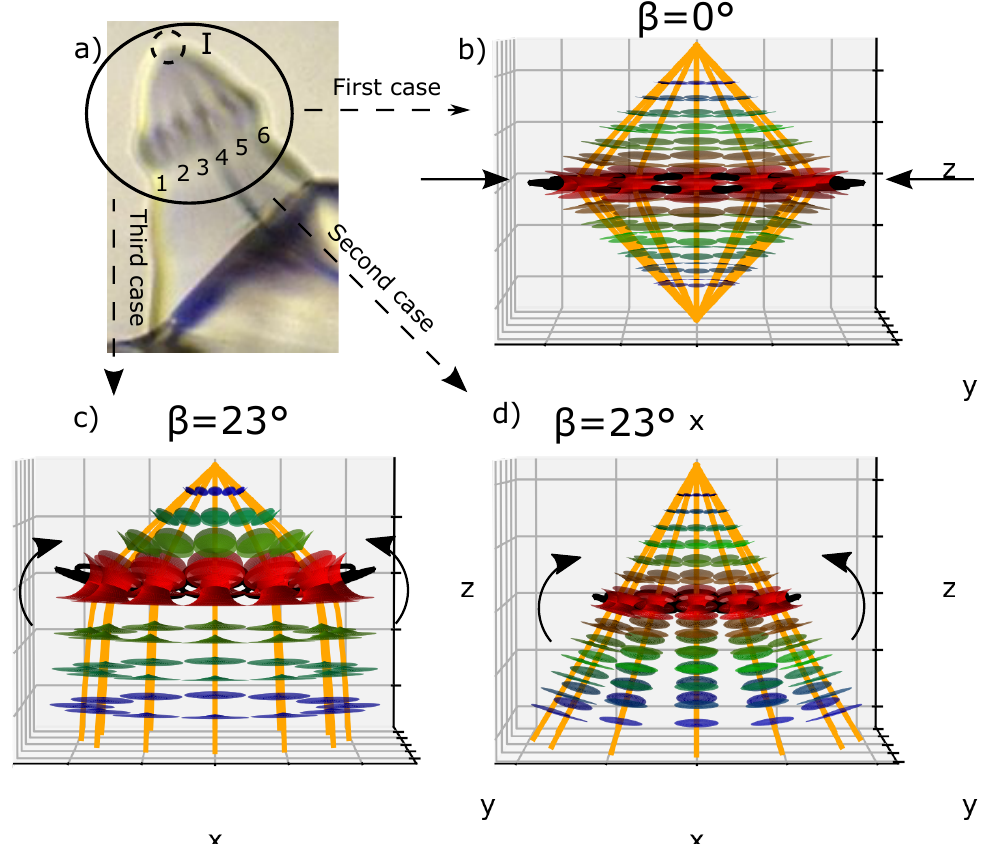
Figure 9. ( a ) Recall of the bâtonnet obtained in POM observation; ( b , c ) represent respectively the flatten and tilted cases of twelve FCDs and their respective smectic layers plotted tangentially to each other according to Friedel’s law (l.c.c.); ( d ) the tilted case of TFCDs with their respective smectic layers.